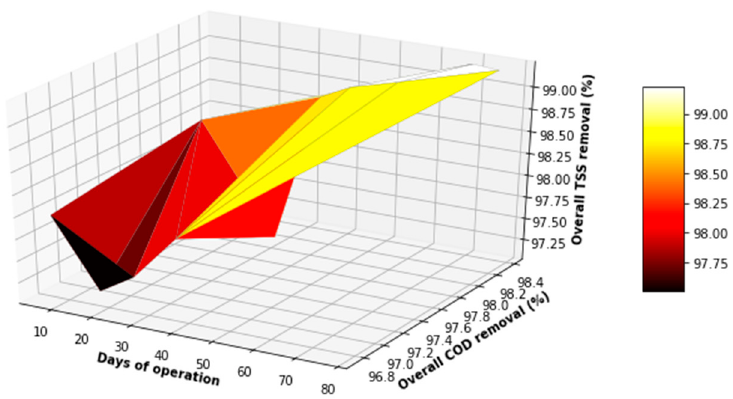
Figure 21. 3D plot of the overall performance (COD VS FOG).